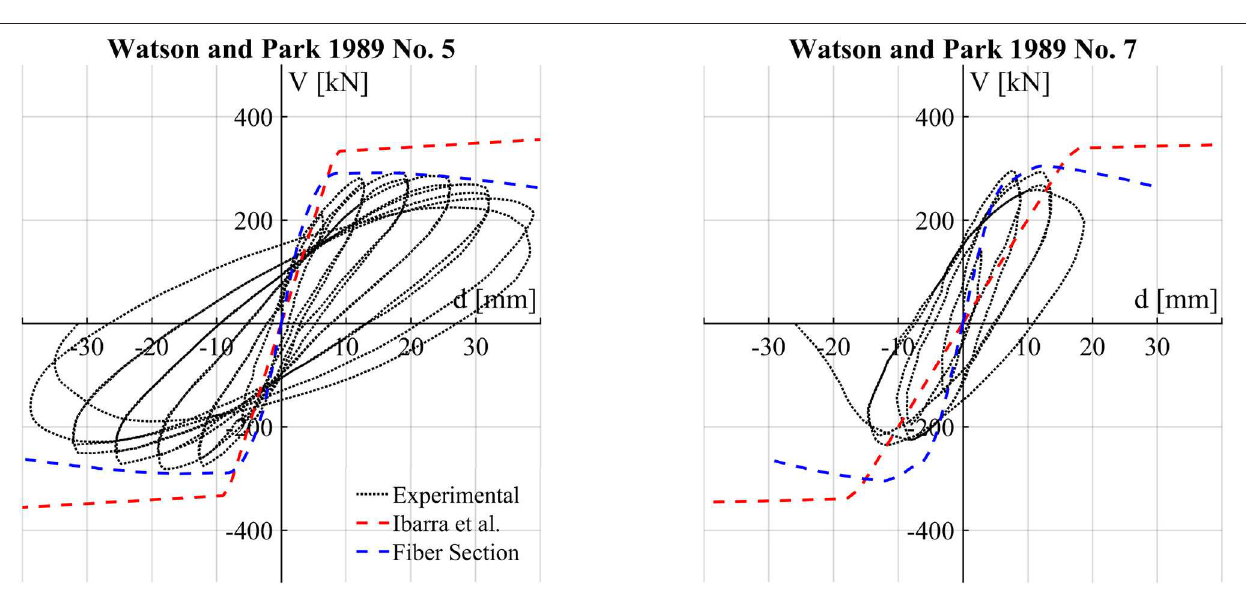
FIGURE 7 | Experimental and numerical cyclic responses of two reinforced concrete columns with high axial loads tested by Watson and Park (1989).